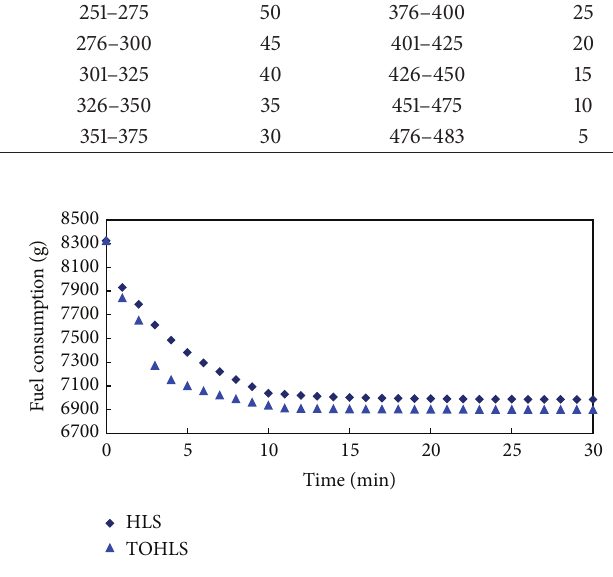
Figure 8: The optimization procedures of HLS and TOHLS for Golden200 when 𝑇 = 30